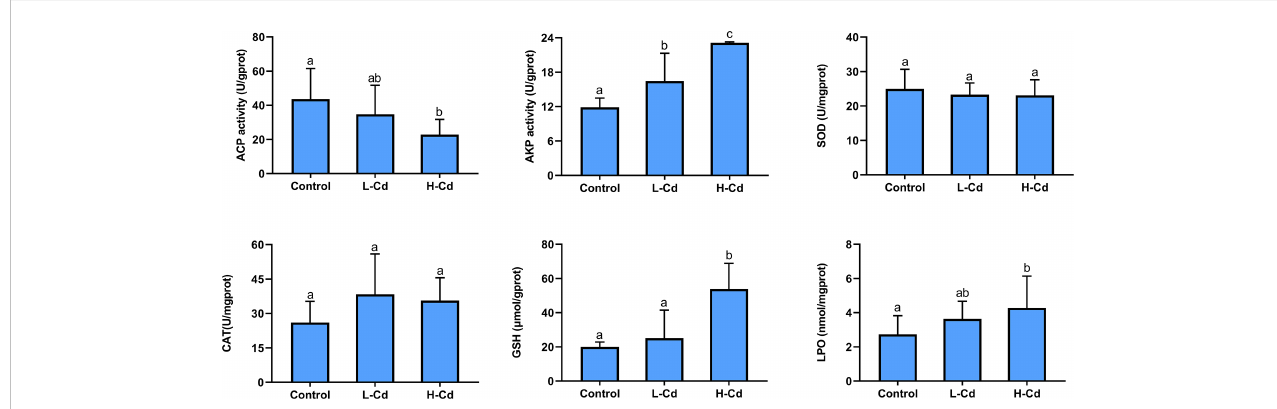
FIGURE 2 The activity of acid phosphatase (ACP), alkaline phosphatase (AKP), superoxide dismutase (SOD) and catalase (CAT), and the levels of glutathione (GSH), and lipid peroxidation (LPO) in the gills of Gigantidas platifrons after 7 days of exposure to 100 or 1000 m g/L Cd (n = 10 per group, mean ± SD). Values followed by the same letter are not statistically different ( P > 0.05) between the treatment groups.